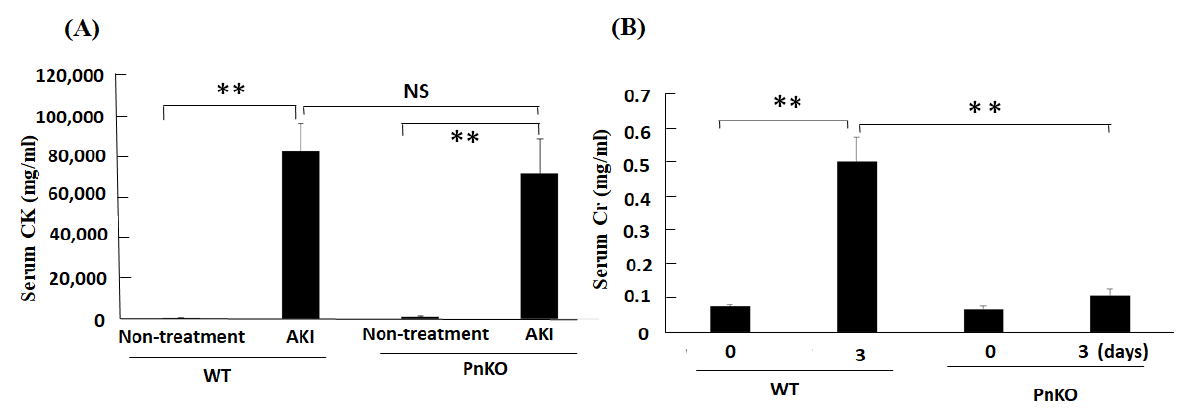
Figure 3. The levels of serum creatinine kinase ( A ) and creatinine ( B ) in wildtype and Pn-null rhabdomyolysis mouse model. ( A ) Serum creatinine kinase was quantified at 6 h later after glycerol injection. ** p < 0.05 vs. Non-treatment. N = 3–5. The levels of serum creatinine ( B ) was quantified at day 0 and 3 after operation. ** p < 0.05 vs. day 0, and day 3 (PnKO). N = 3–5.